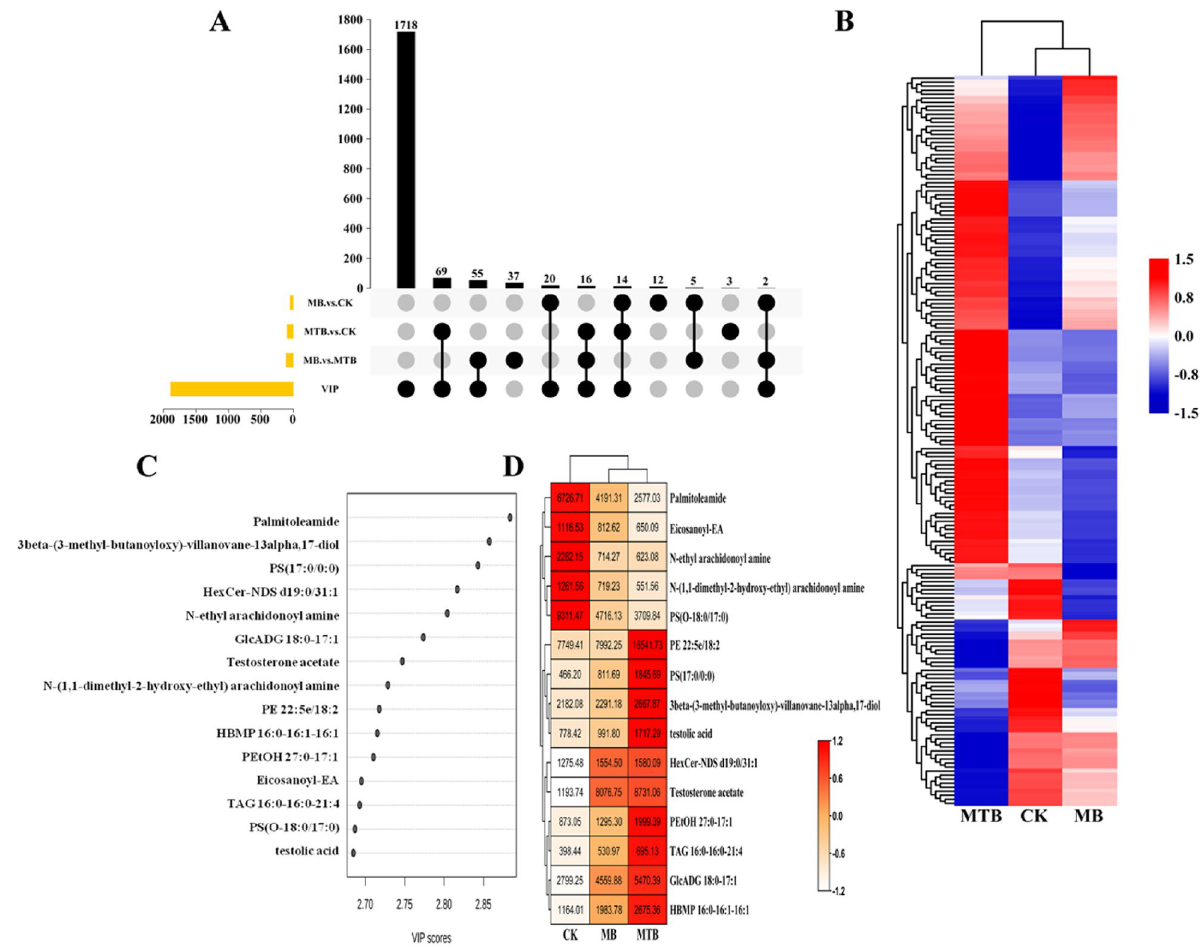
Figure 2. Specific pattern of lipids contents in BAM was induced by MTB- and MB-infection. ( A ) Up-set diagrams representing the overlap of identified differentially expressed lipids in each pairwise comparison. ( B ) Pattern of content variation of differential lipids. The highly increased lipids were shown in red, and the decreased lipids were labeled by green. ( C ) VIP scores of lipids among three experiment treatments. ( D ) Heatmap displaying the level of top 15 lipids (based on VIP score) in each treatment. The scale showed the normalized mean peak area of lipids in each group, and the origin value were shown in